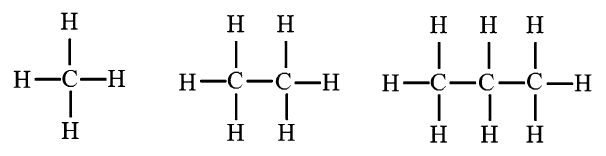
Fig. 1 Molecular structure of methane, ethane, and propane (Garner and Ham 1939)